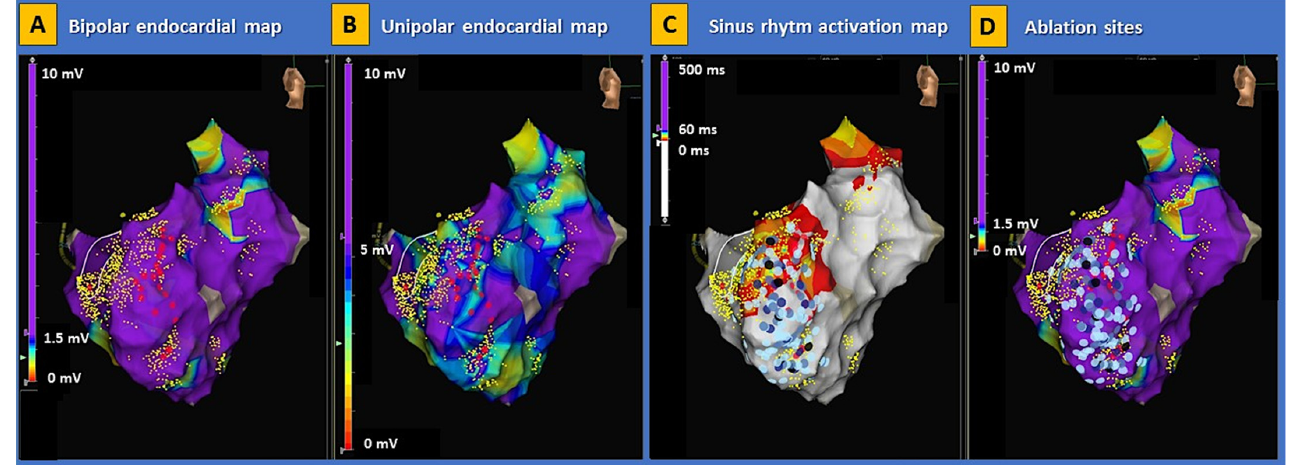
Figure 4. Electroanatomical substrate of Brugada syndrome. Examples of electroanatomical map abnormalities involving the right ventricle are shown in a patient with genetically proven BrS. The disproportion between low-voltage areas in bipolar (panel ( A )) and unipolar (panel ( B )) endocardial maps indicates the presence of a deep arrhythmogenic substrate consistent with classic arrhythmogenic right ventricular cardiomyopathy. The activation map during sinus rhythm (panel ( C )) shows an extensive area of late potentials within the basal lateral segment of the right ventricle. In this patient, radiofrequency energy was extensively delivered (panel ( D )), aimed at the complete abolishment of abnormal potentials in the right ventricle. No ventricular arrhythmias were induced on post-procedural programmed ventricular stimulation. BrS = Brugada syndrome.